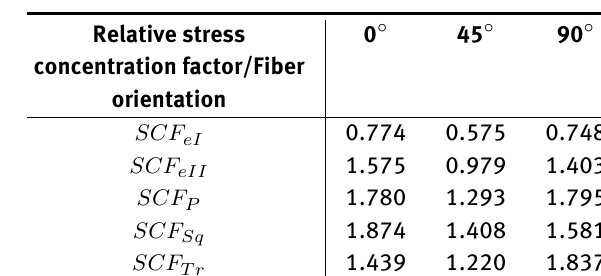
Table 7: Relative stress concentration factors for different shapes